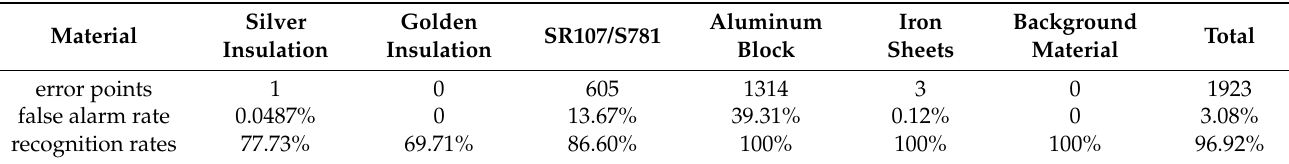
Figure 11. Spectral characteristic curve of space debris material.